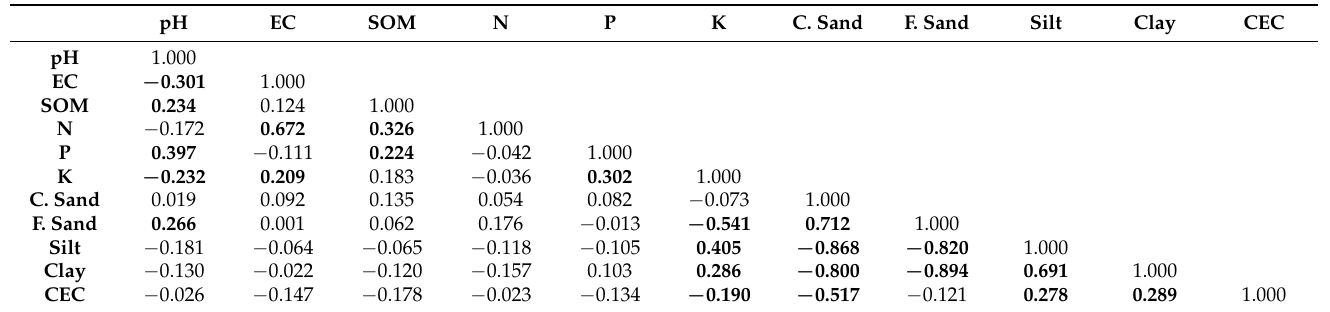
Table 8. Spearman correlation matrix of soil physical–chemical parameters in the 20–40 cm layer.